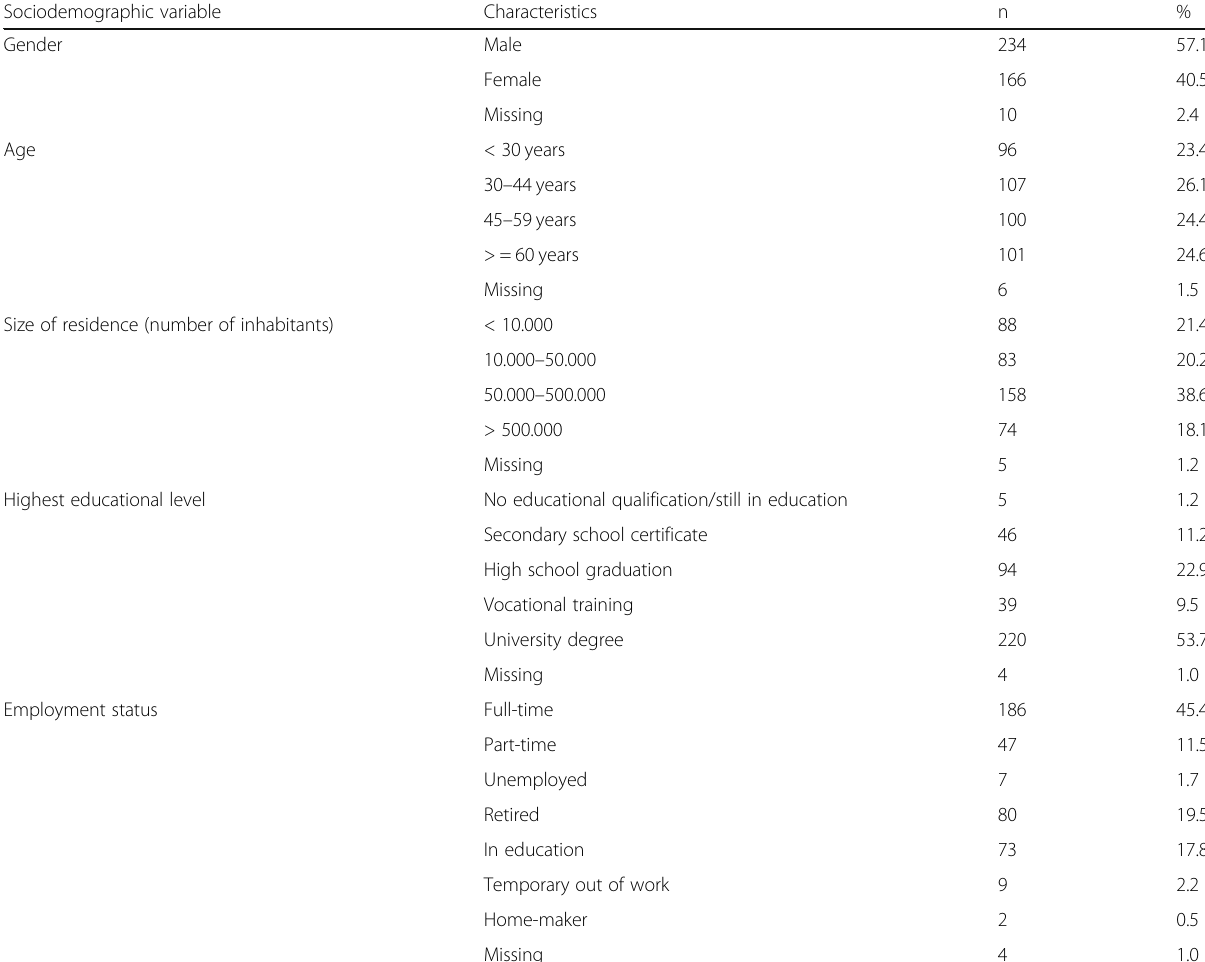
Table 3 Sociodemographic characteristics of the sample ( N = 410) Sociodemographic